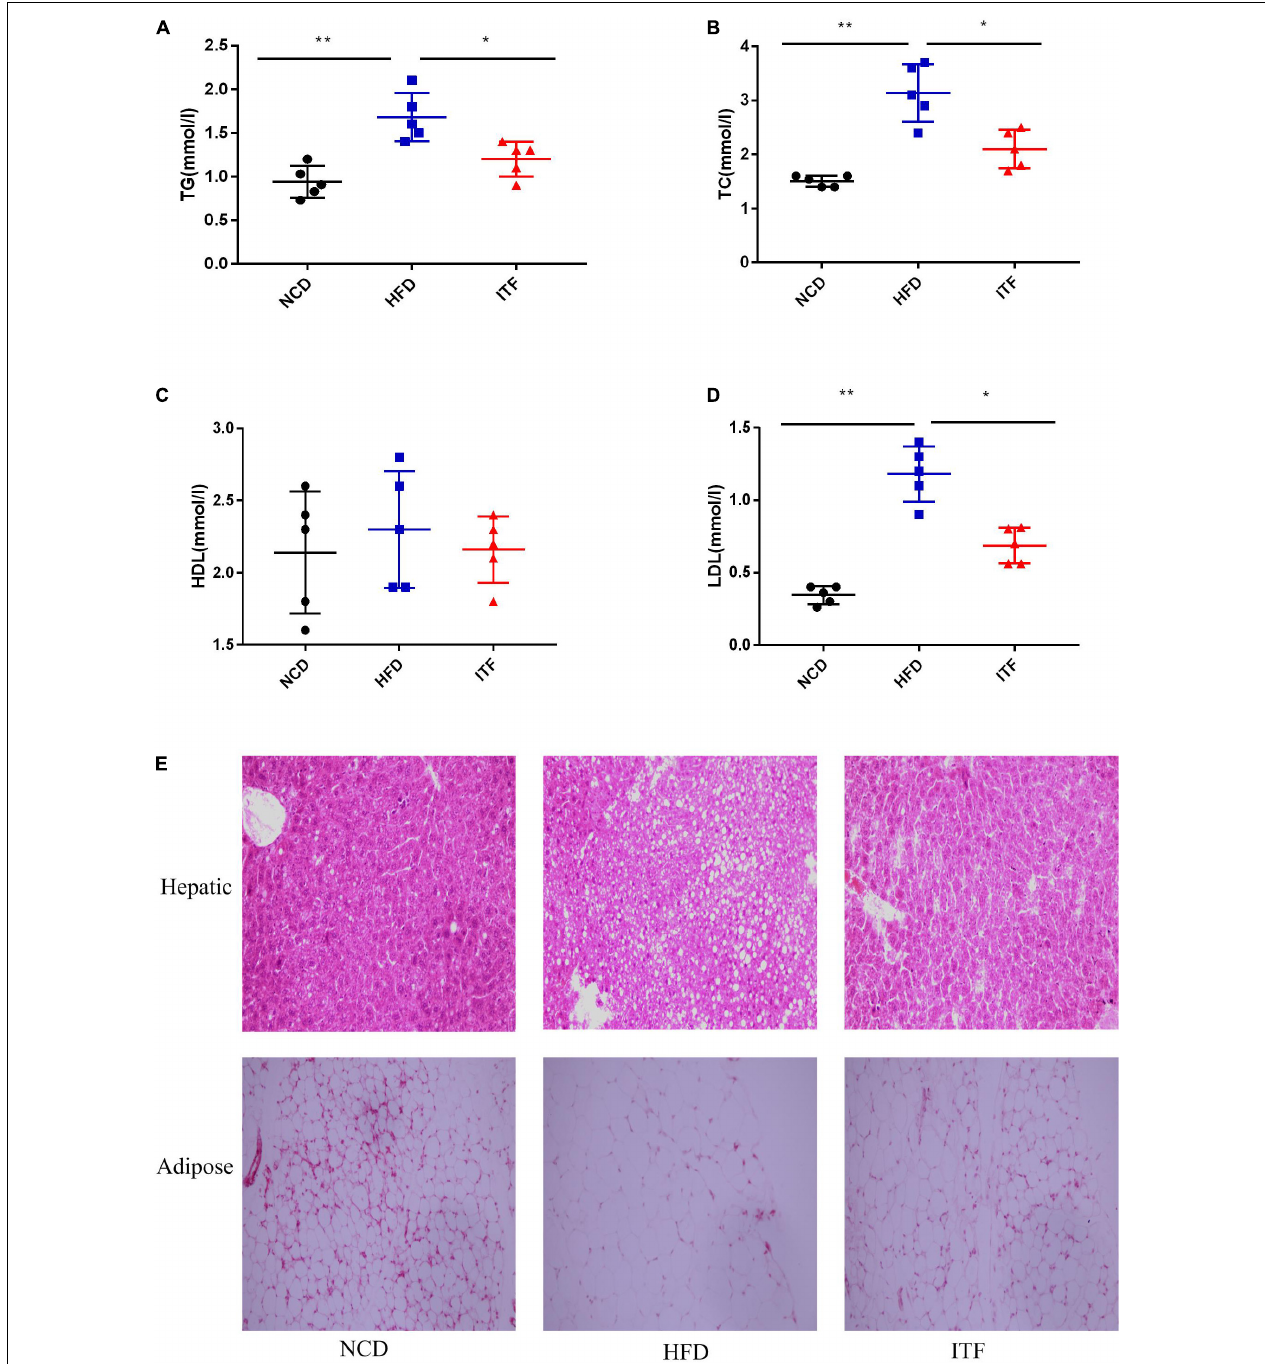
FIGURE 2 | Improvement in metabolic parameters in HFD-induced gestational diabetes mice by ITF. (A) Serum TG. (B) Serum TC. (C) Serum HDL-C. (D) Serum TC LDL-C. (E) Representative H&E-stained images of the hepatic and adipose tissues ( × 200). TG, triacylglycerol; TC, total cholesterol; HDL-C, high-density lipoprotein cholesterol; LDL-C, low-density lipoprotein cholesterol. Data were analyzed using one-way ANOVA followed by the Tukey post hoc test for panels (A–D) . * p < 0.05, ** p < 0.01.